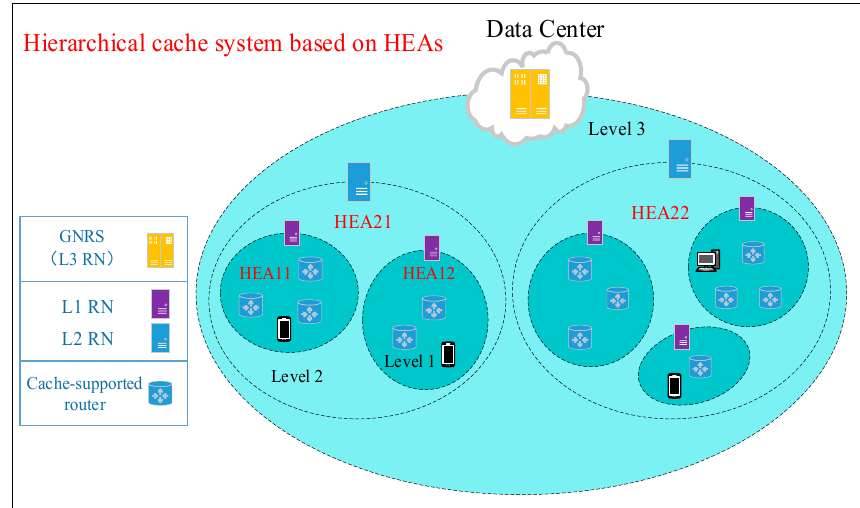
Figure 1. Overview of a hierarchical cache system.